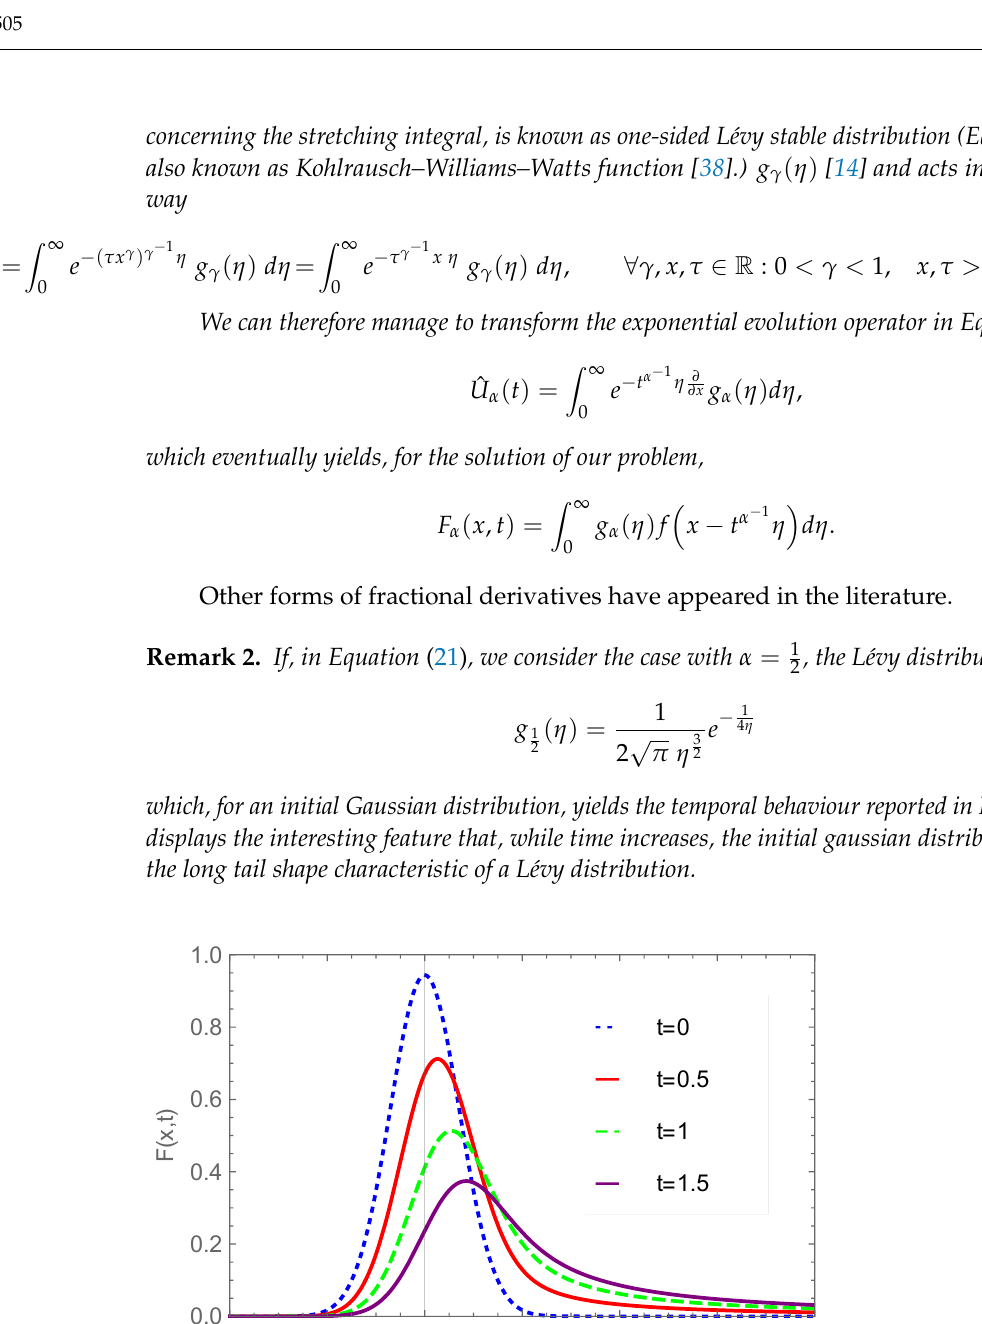
and initial function f ( . ) 2